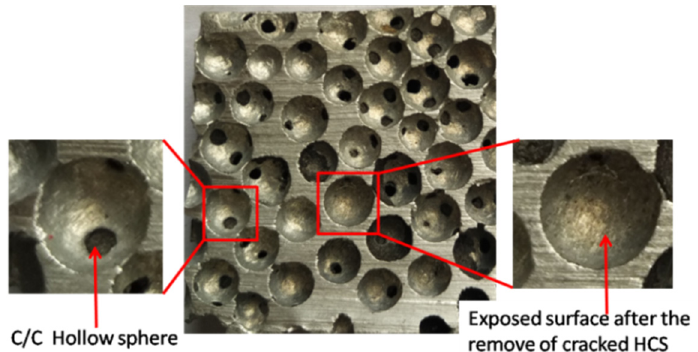
Figure 6. Image of the cross-section showing spherical cavities after the removal of cracked HCSs.